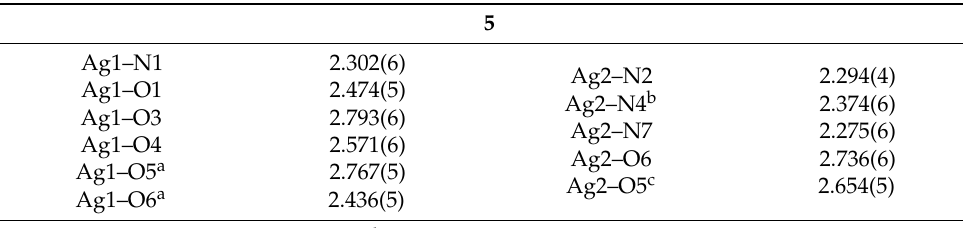
Table 3. Selected bond lengths (Å) for compound 5 .